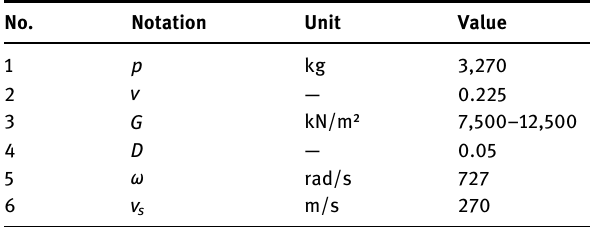
Table 8: Soil parameters used for the simpli fi ed model of vibration decay